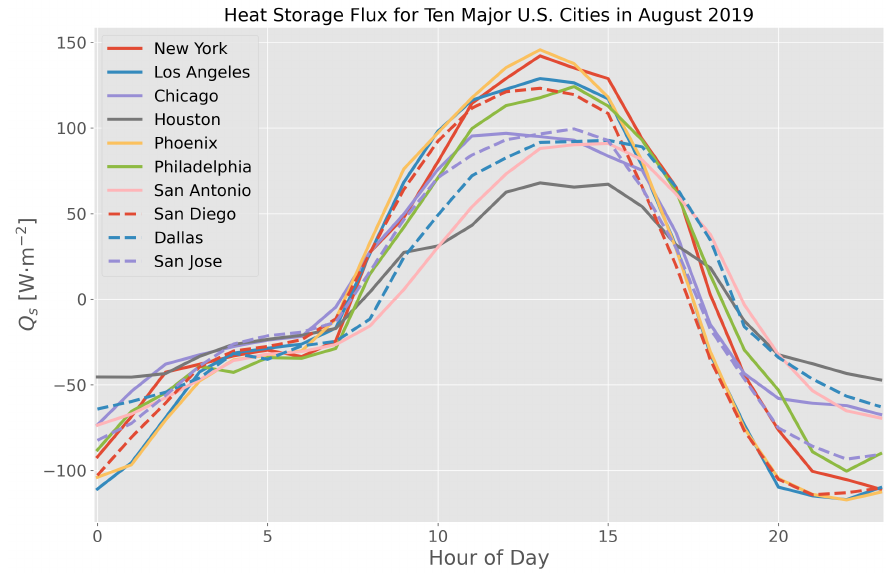
Figure 7. Mean diurnal heat storage flux for August 2019 across all ten major U.S. cities using the satellite-derived thermal variability scheme (TVS).